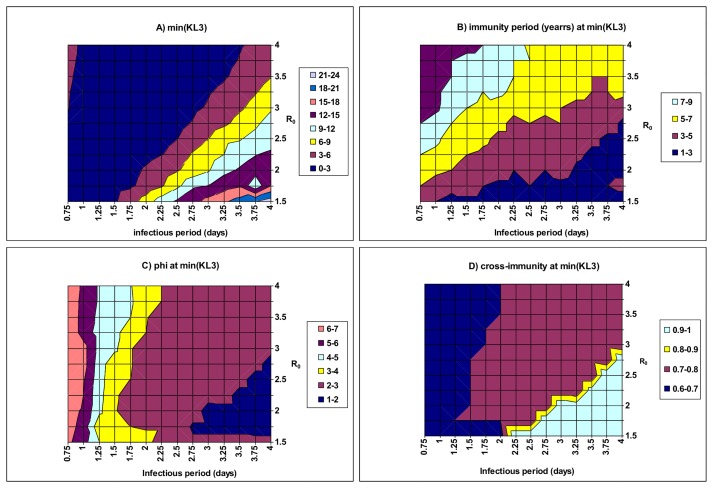
The minima of the combined KL information distance (KL3) as a function of the infectious period (d
I) and the basic reproductive number (R
0).For each pair of d
I and R
0, the best fit parameters were searched over the following space, ϕ: [1,7] gridded evenly into 71 points, ψ: [0,1] gridded evenly into 21 points and D: [1,10] years gridded evenly into 21 points. It is assumed that the co-transmission rate β
d = β/4 and the external force of infection (ε) is fixed at 4.1×10−9 per person per day. A) shows that there is a positive correlation between d
I and R
0: when R
0 is about 1.5, d
I is <2.1 day; whilst when R
0 = 2.5 d
I should be <3.5 days. B) shows that the immunity period decreases with d
I but increases with R
0; C) shows that for a given R
0, infectivity enhancement (ϕ) required to generate the observed patterns of seasonal influenza decreases with d
I; D) shows that cross-immunity increases with d
I but decreases with R
0.